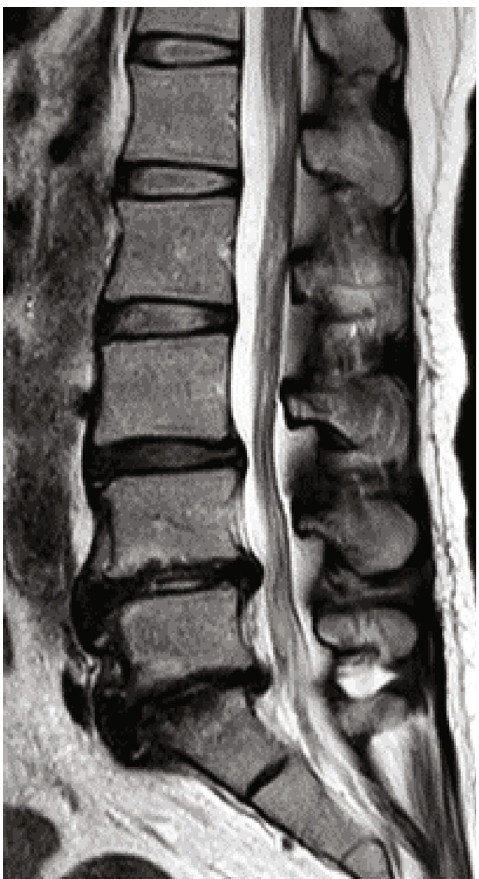
Figure 2: T2-weighted magnetic resonance imaging (MRI) of the lumbar spine of a 49-year-old woman with degenerative lumbar disease. Midsagittal